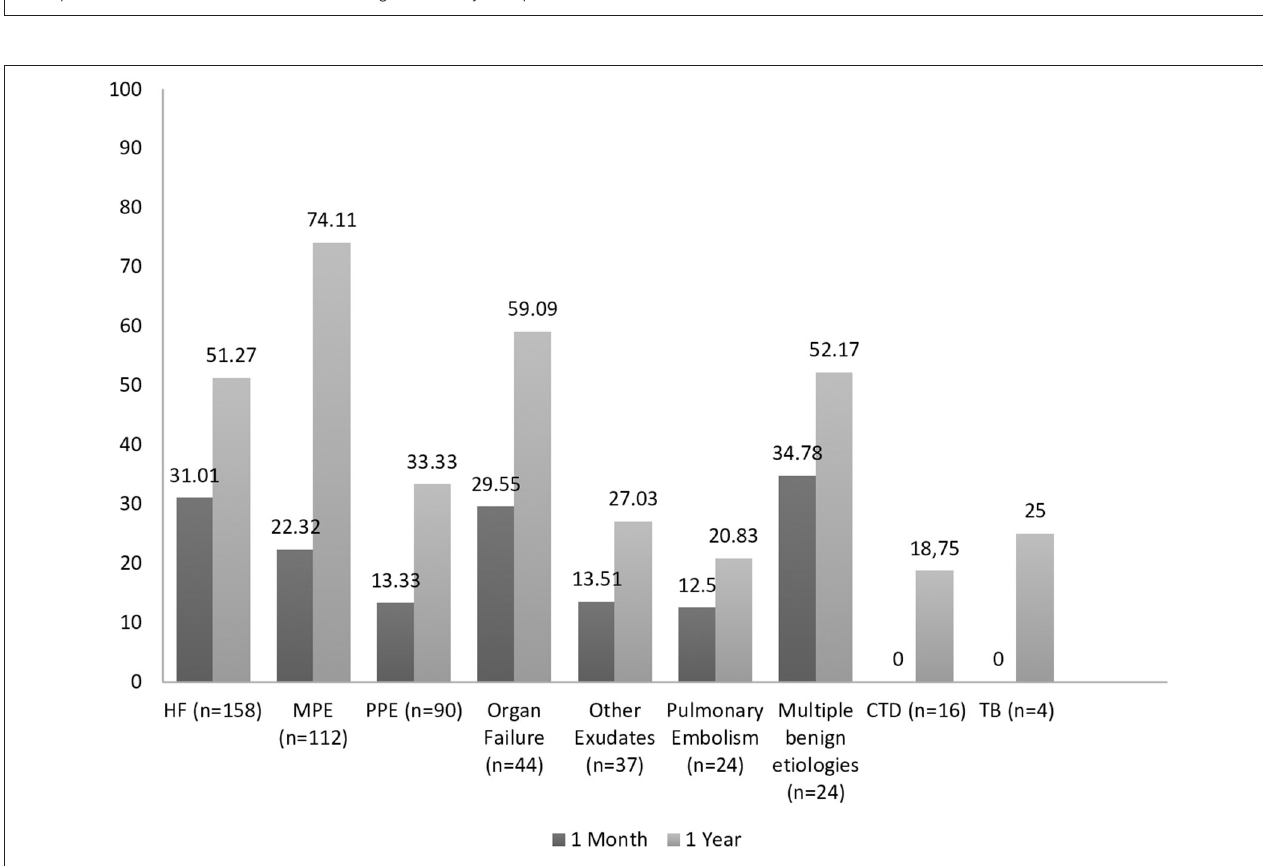
FIGURE 2 | Percent mortality based on the diagnosis of the PE. Short-term mortality was higher for pleural effusions secondary to organ failure, while patients with MPEs experienced the worst prognosis at 1 year.